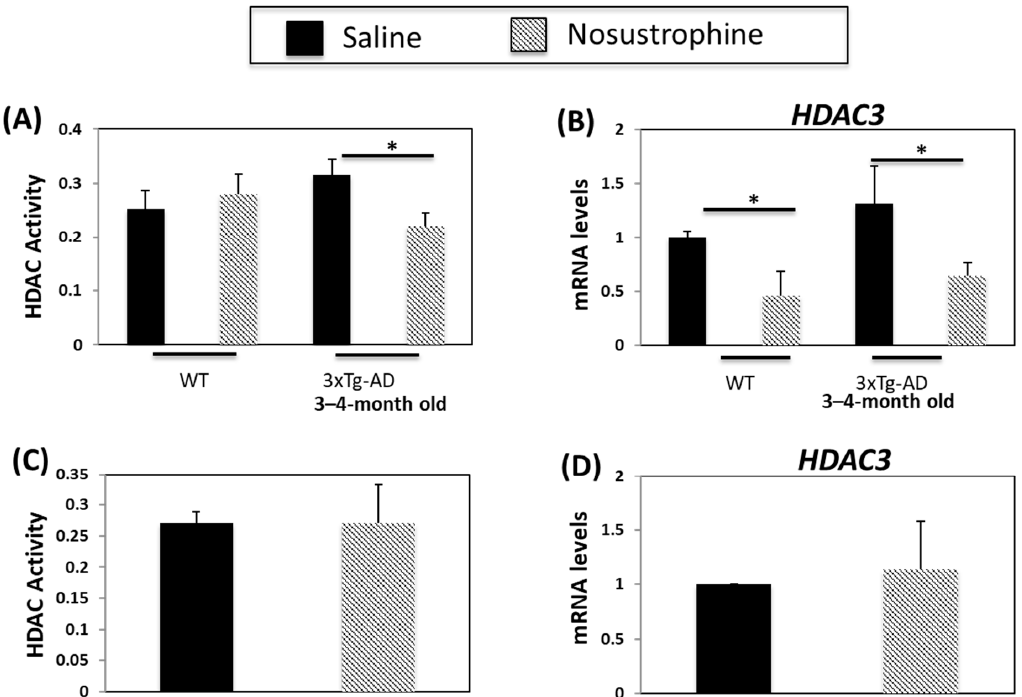
Figure 11. Nosustrophine regulates HDAC activity and HDAC3 expression. HDAC activity was measured in wild-type and young (3–4-month-old) ( A ) and older (8–9-month-old) ( C ) 3xTg-AD mice ( n = 4 animals per group). HDAC31 mRNA levels were also measured by qPCR in wild-type and young ( B ) and old ( D ) 3xTg-AD mice. Results are expressed as fold-change compared to saline-treated wild-type- or trigenic mice. Data are expressed as means ± S.E.M. * p < 0.05.